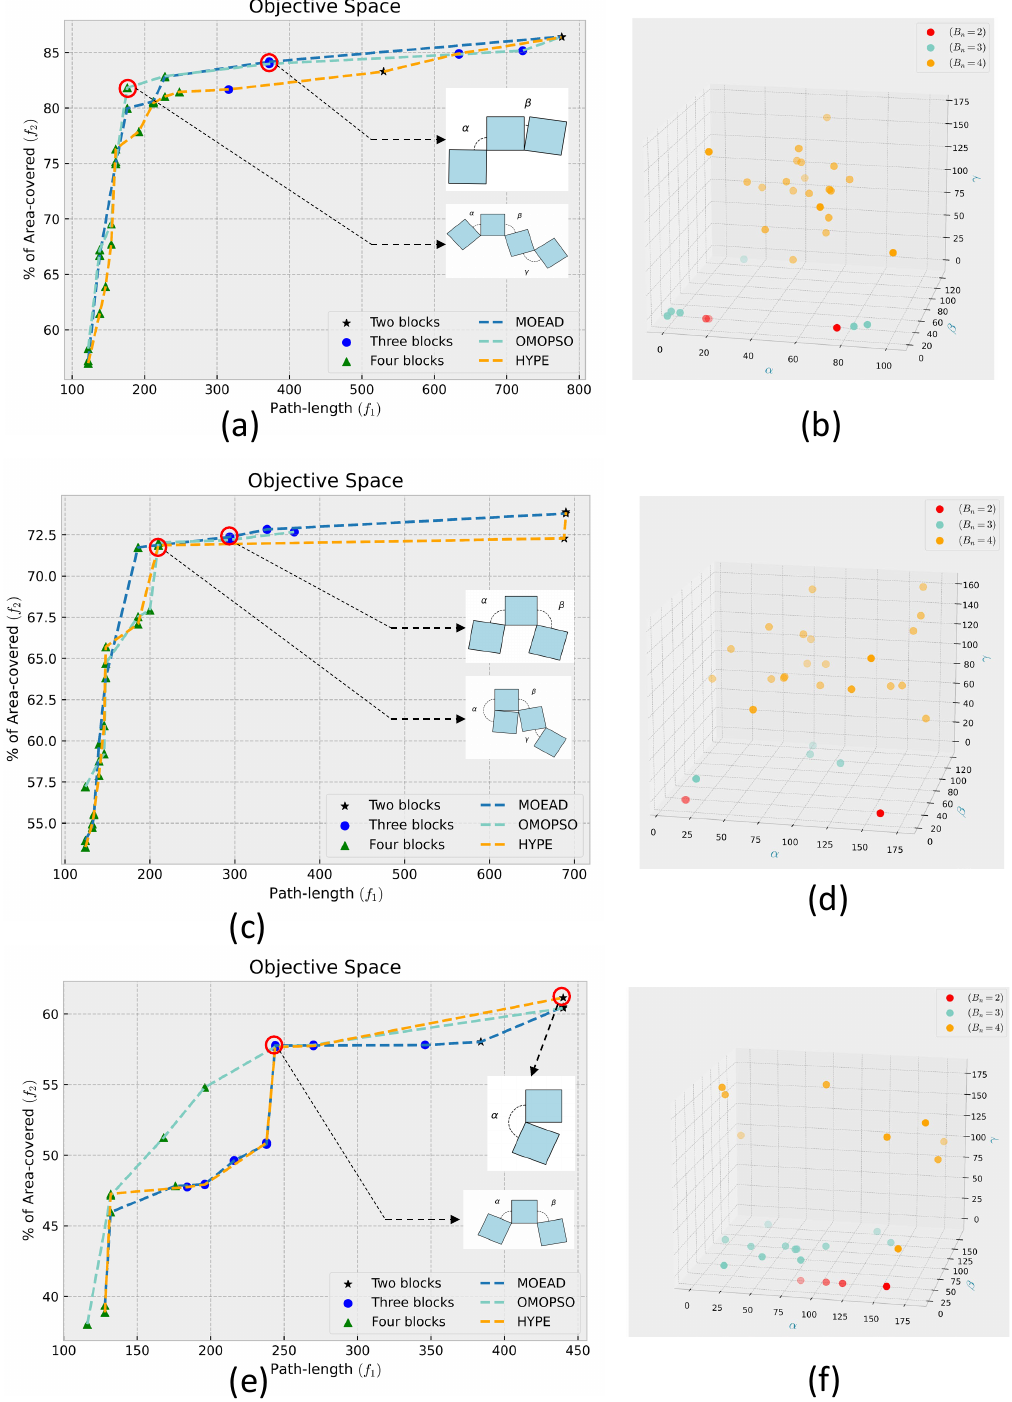
Figure 8. Simulated Pareto front and design variables in ( a , b ) Environment-1, ( c , d ) Environment-2, and ( e , f )